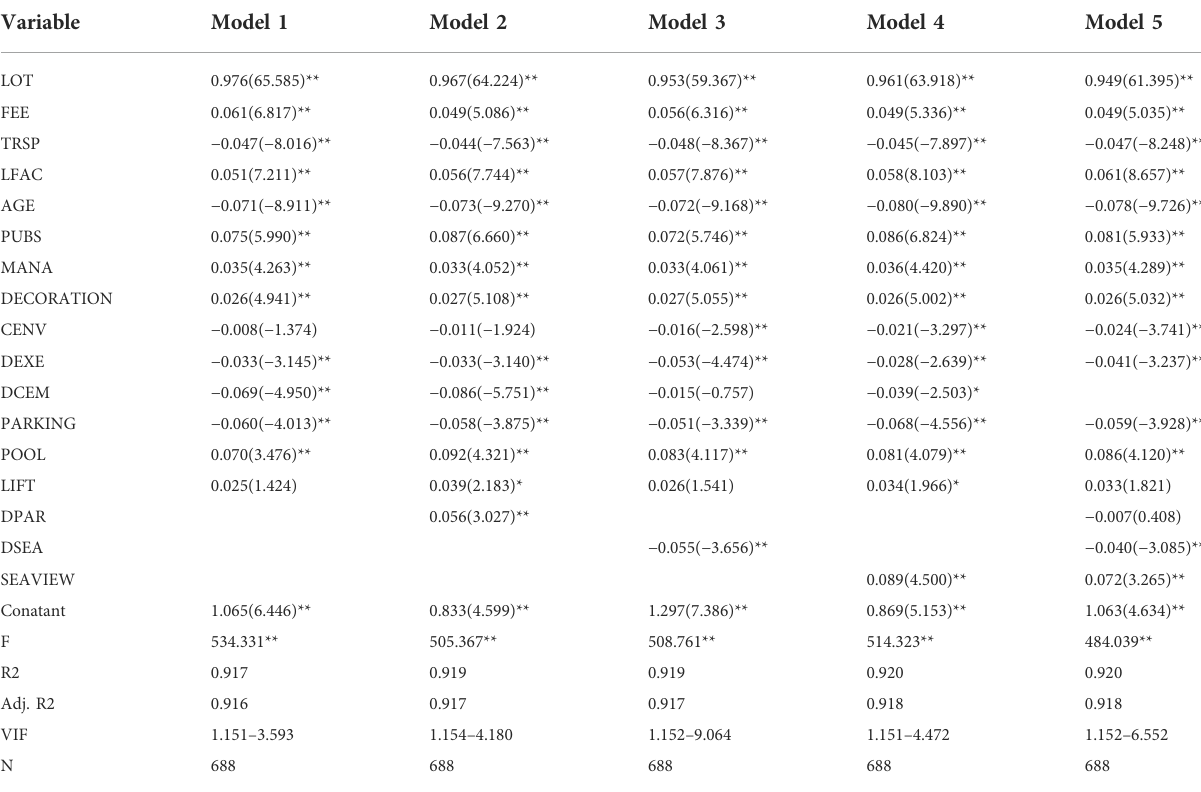
TABLE 3 Results of multiple linear regression